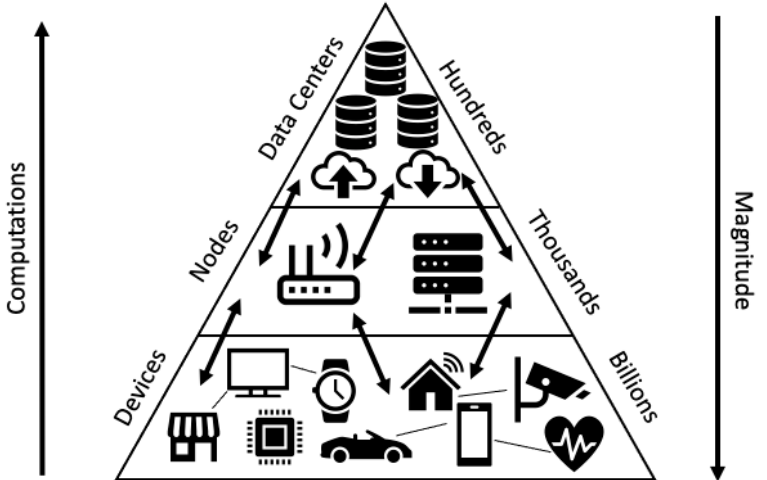
Figure 1. Offloading variations that exist across a multi-layered IoT architecture.